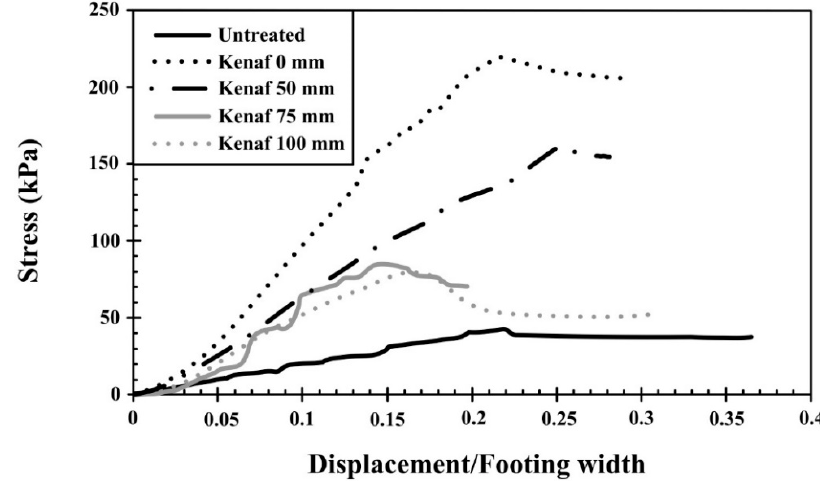
Figure 18. Variation in vertical stress and displacement/footing width (modified from Rashid et al.